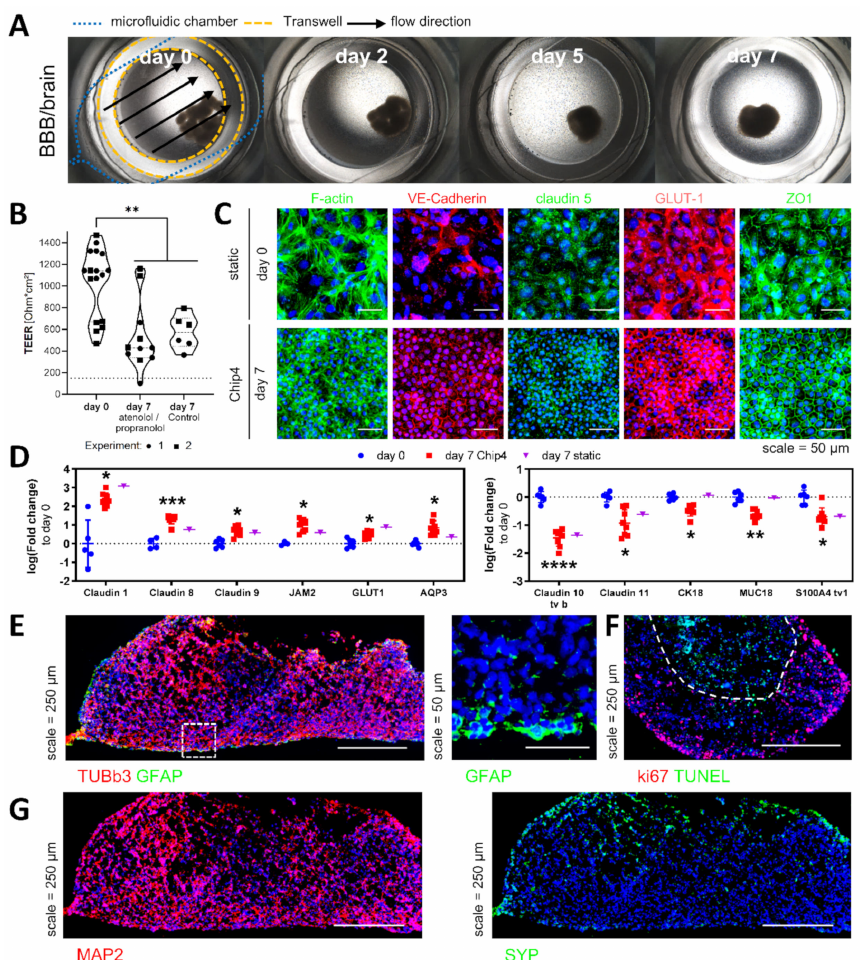
Figure 4. Organ models in the HUMIMIC Chip4: liver and BBB/brain model. ( A ) Brightfield images of the BBB/brain compartment over one week in the HUMIMIC Chip4 in coculture with the liver model. In the image of day 0 of culture, exemplarily, the location of the microfluidic chamber, of the Transwell and the flow direction are shown. ( B ) TEER values before and after 7-day culture in the Chip4 with and without substance addition, from two experiments (N = 2) with 3–5 chip replicates per group ( n = 3–5). One-way ANOVA with Tukey post hoc test, ** p < 0.01. ( C ) Immunofluorescence staining of endothelial and BBB marker in iPSC-derived BMEC-like cells culture before and after 7-day culture in the Chip4; scale is 50 µ m. ( D ) Significantly upregulated and downregulated genes in BMEC-like cells after chip culture compared to day 0 and to day 7 in static culture. Data are expressed as a logarithmic fold change to the day 0 samples. Six samples from three experiments on day 0 (N = 3), eight samples after Chip4 cultivation in three experiments (N = 3) and one sample from day 7 in static culture (N = 1) were analyzed. The expression levels of individual samples and mean ± s.e.m are shown. Statistical significance was determined by multiple t -tests using the Holm–Sidak method to correct for multiple comparisons, **** p < 0.0001, *** p < 0.001, ** p < 0.01, * p < 0.05. Each gene was analyzed individually, without assuming a consistent standard deviation (SD). ( E ) Left image: immunofluorescence staining of TUBb3 positive neuronal progenitor and GFAP positive glial progenitors in neural spheroids after 7-day culture in the Chip4; scale is 250 µ m. Right image: Magnification of the GFAP staining in the region marked in the left image; scale is 50 µ m. ( F ) Immunofluorescence staining of ki67-positive proliferating cells and TUNEL-positive apoptotic in neural spheroids after 7-day culture in the Chip4; scale is 250 µ m. Border between the outer layer of proliferating cells and apoptotic cells in the spheroid core is marked by a dashed line. ( G ) Immunofluorescence staining of MAP2 positive neurons and synaptophysin (SYP) as a marker of synapse formation, stained after 7-day culture in the Chip4; scale is 250 µ m. For all immunofluorescence staining: cell nuclei were stained with DAPI in